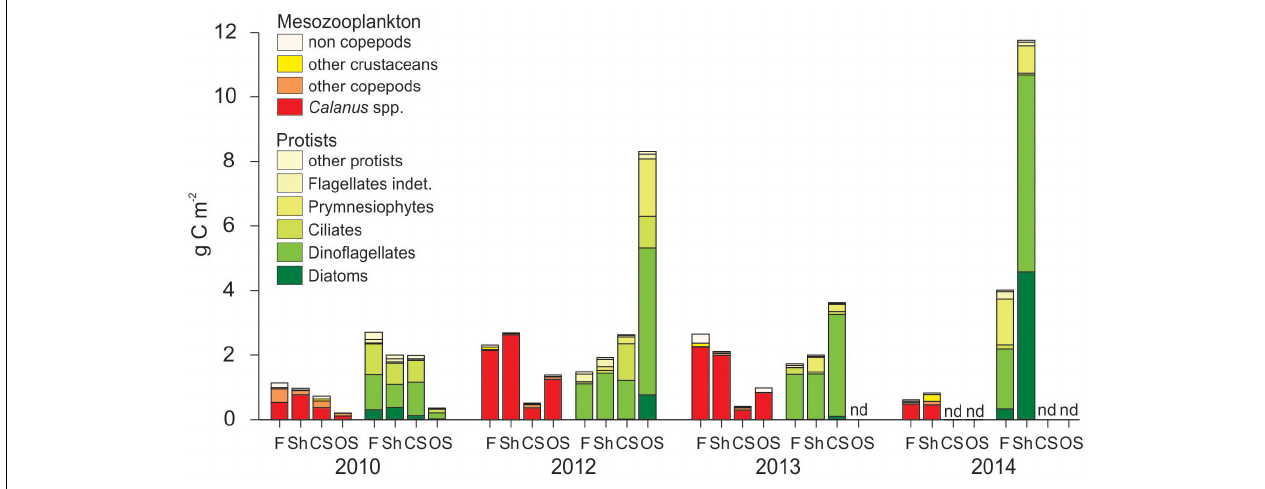
FIGURE 8 | Depth-integrated (0–50 m) protists and mesozooplankton carbon standing stock (g C m − 2 ) in the four regions (F, fjord; Sh, shelf; CS, continental slope; OS, off-shelf) along the transect from Rijpfjorden to the Arctic Ocean in 2010, 2012, 2013, and